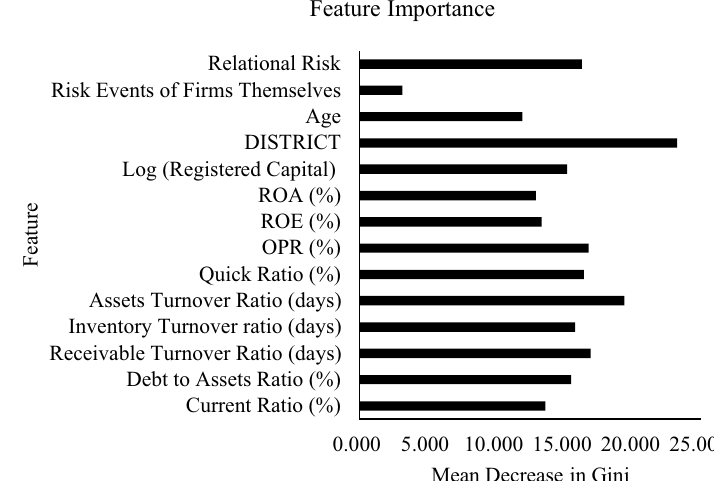
Fig. 7 Random forest feature importance. A greater mean decrease in Gini indicates a more important